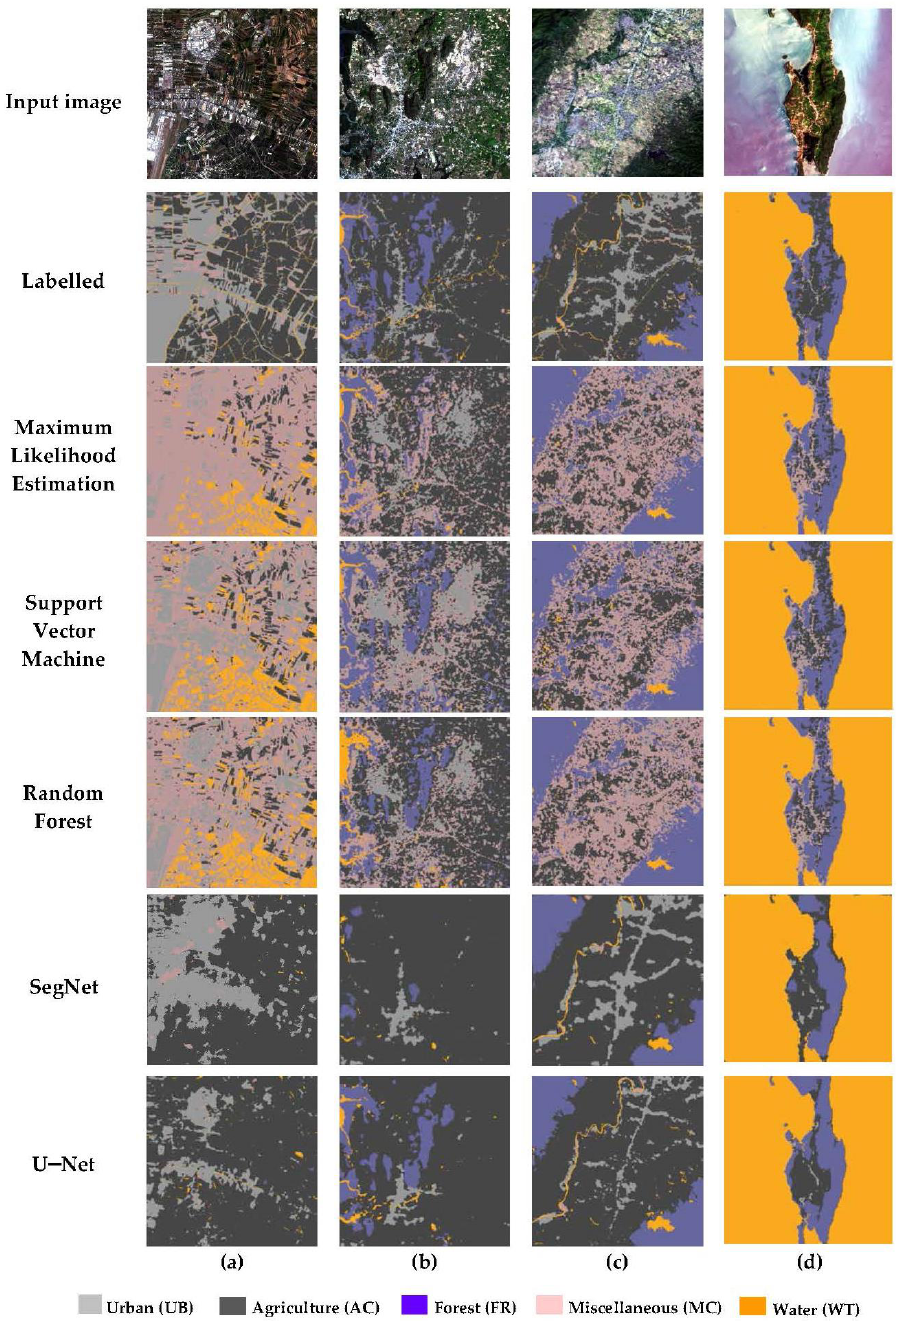
Figure 6. The classification results and segmentation results of land use features on the land use dataset. ( a ) urban and agriculture area; ( b ) urban, agriculture, and forest areas in countryside; ( c ) urban and agriculture areas in valley; ( d ) urban, agriculture and forest areas on island.